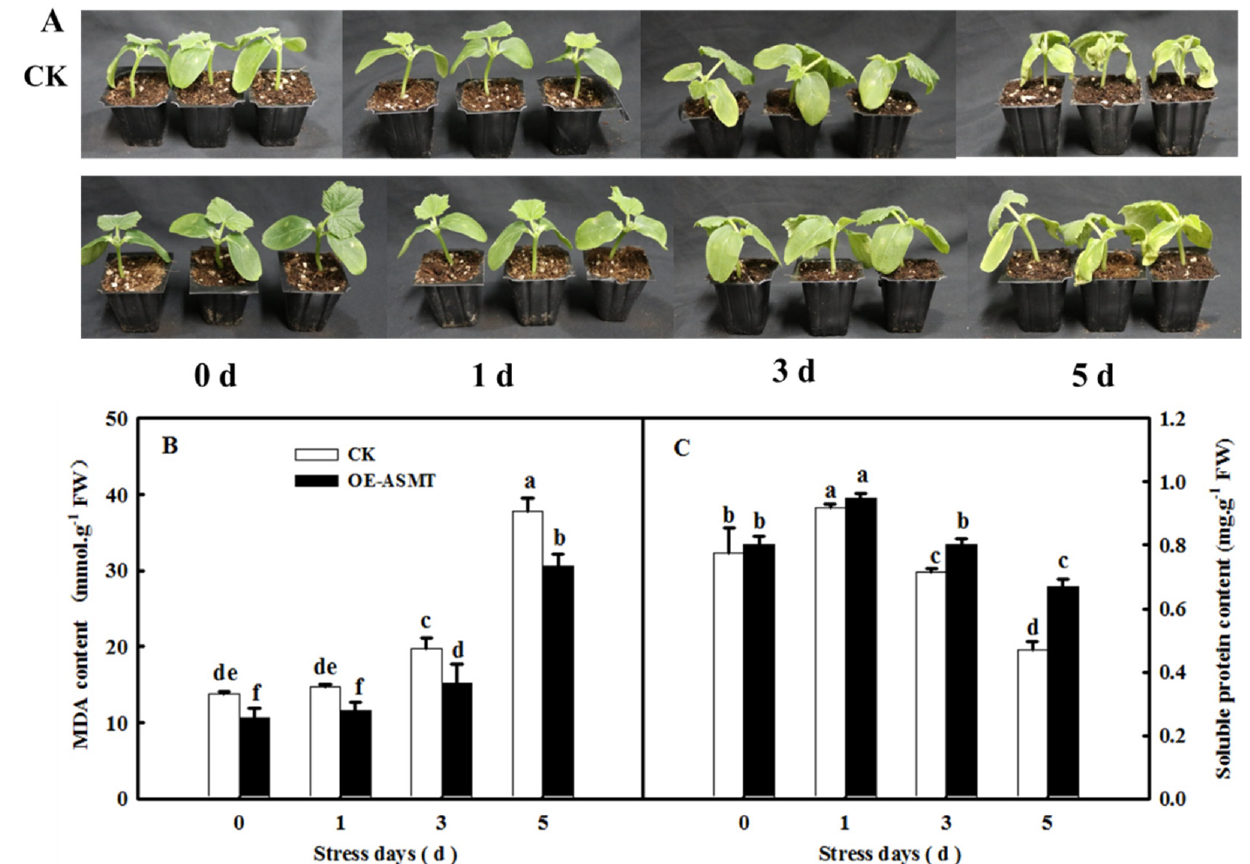
Figure 2. The effect of CsASMT transient overexpression on senescence of leaves under dark condition. ( A ) The phenotype of cotyledons; ( B ) MDA content; ( C ) soluble protein content. The CsASMT transient overexpression plants with two cotyledons were displaced into growth chambers and treated with dark condition (day/night temperature: 25 ◦ C/18 ◦ C). The cotyledons were collected for the determination of MDA and soluble protein contents at 0, 1, 3, and 5 days. All values shown are mean ± SD ( n = 3). a–f indicate that mean values are significantly different among samples ( p < 0.05). 2.3. Effects of ASMT Overexpression on ROS Content in Cucumber Leaves in Which Senescence Was Induced by Darkness As shown in Figure 3A, the H 2 O 2 and O 2 − contents of cucumber cotyledons in control and CsASMT overexpression plants increased gradually (Figure 3A,B), and after 5 days of darkness, the contents of H 2 O 2 and O 2 − in leaves of overexpressed CsASMT plants were significantly lower than those of the control, decreasing by 29.5% and 15.7%, respectively. In accordance with the change in ROS content, the diaminobenzidine (DAB) and nitroblue tetrazolium (NBT) staining (Figure 3C) results confirmed that ROS increased significantly in both treatments and that ROS content was higher than that in CsASMT -overexpressing plants under